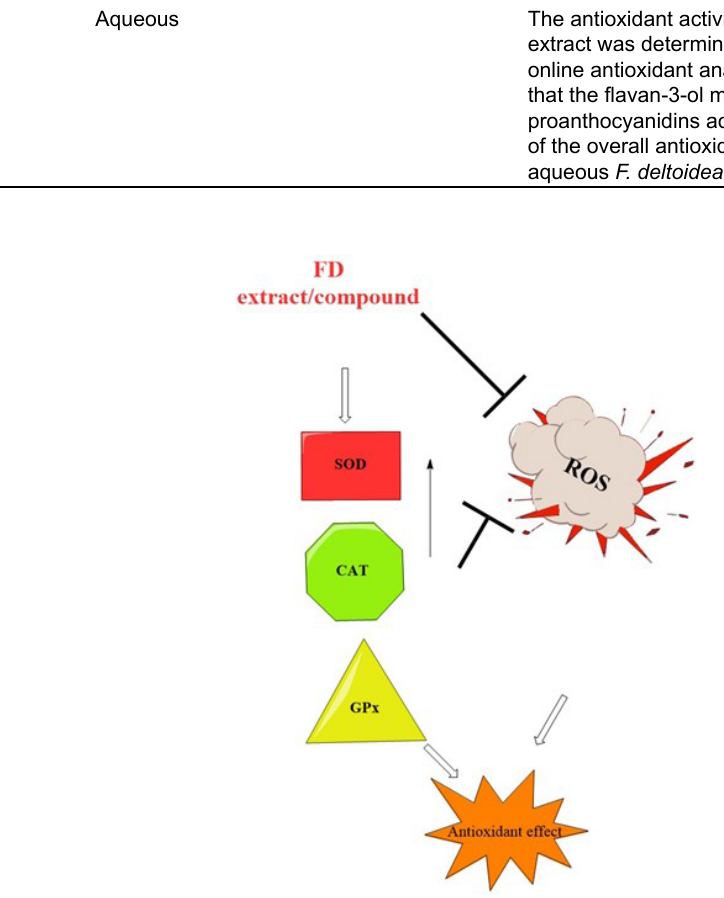
Figure 2. Possible mechanism of antioxidant activities of FD; SOD, CAT, GPx (antioxidant enzymes) Anti-inflammation